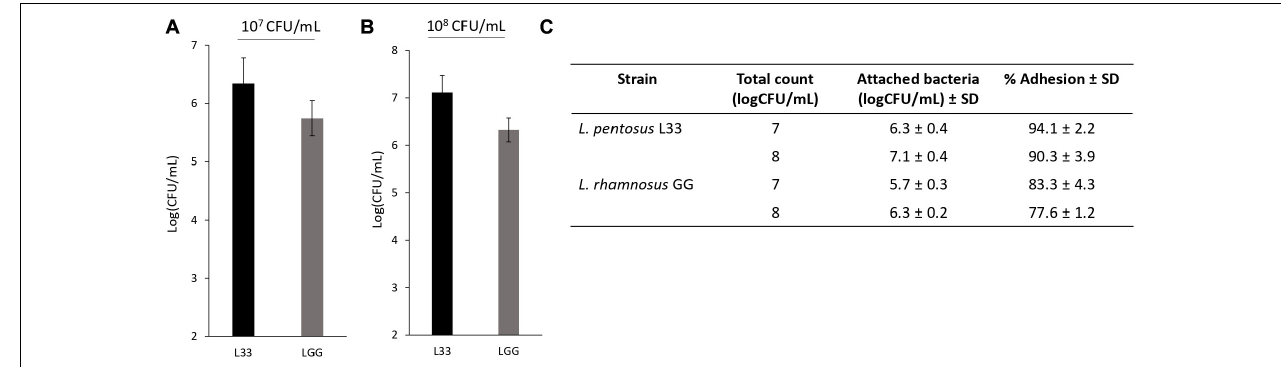
FIGURE 8 | Assessment of the adhesion capacity of L. pentosus L33 by quantitative analysis. L. rhamnosus GG was used as a reference strain. (A) Adhesion capacity of viable cells at a concentration of 10 7 CFU/mL to HT-29 cells after 4-h co-incubation. (B) Adhesion capacity of viable cells at a concentration of 10 8 CFU/mL to HT-29 cells after 4-h co-incubation. (C) Adhesion (%) of attached bacteria to initial added total count. The data presented are the mean ± standard deviation of three independent experiments performed in